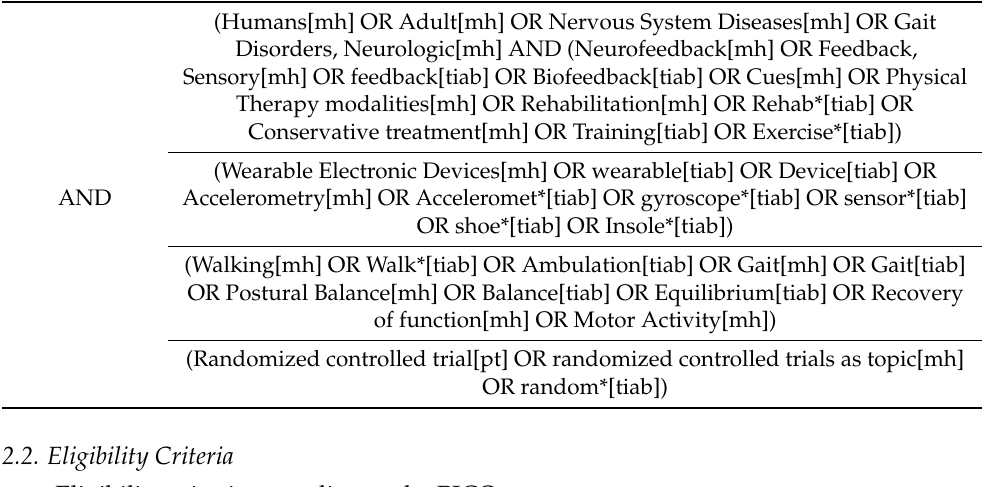
Table 1. Search strategy example on